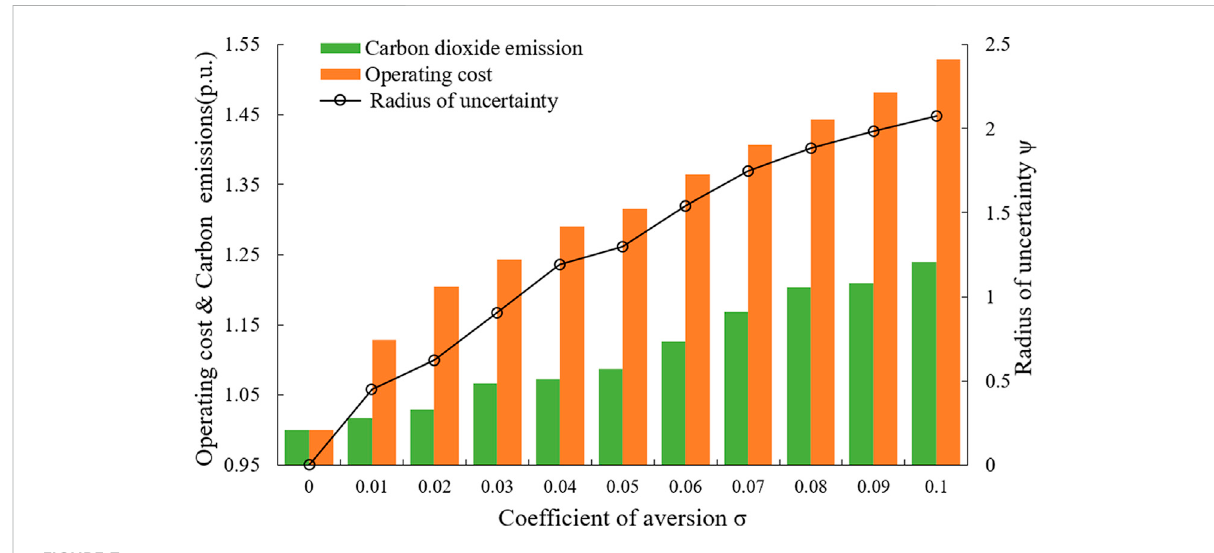
FIGURE 7 Trends in operating cost, carbon emissions and uncertainty radius.